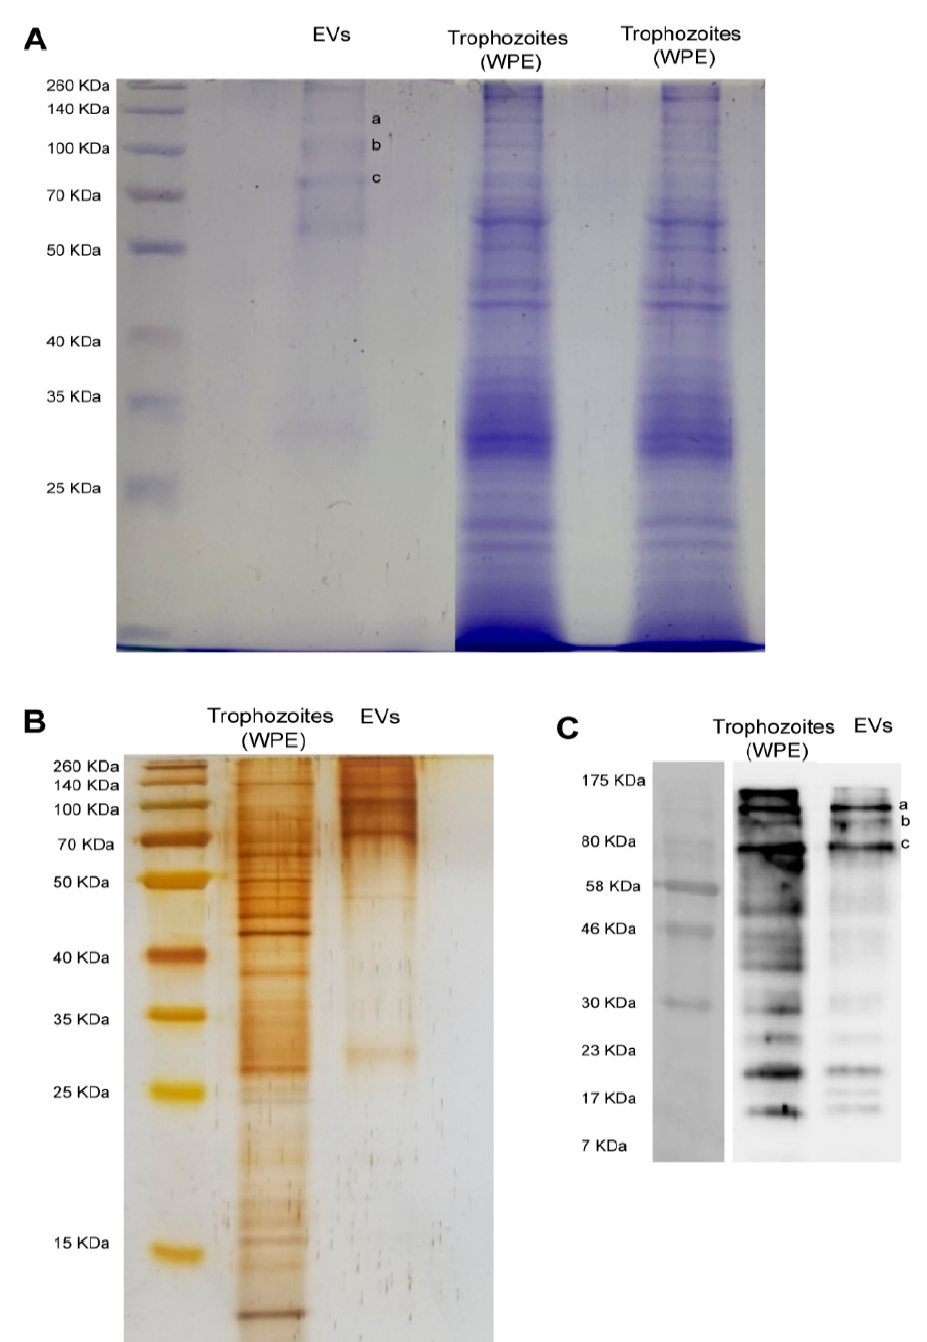
Figure 4. Electrophoretic (SDS-PAGE) protein profile of extracellular vesicles and protein recognition by polyclonal anti- Naegleria fowleri antibodies using Western blot. ( A ) Coomassie and ( B ) silver stains showing similar band patterns in extracellular vesicles, which range from >25 KDa to 260 KDa; EVs: extracellular vesicles; WPE: whole protein extracts of trophozoites of N. fowleri . For Coomassie stain, approximately 30 µ g of protein/sample were loaded onto the gel and for silver stain, approximately 9 µ g of protein/sample were loaded onto the gel. ( C ) Western blot showing the recognition of 3 intense bands over 70–80 KDa (( C ), a–c) and 3 less intense bands under 23 KDa, using the polyclonal anti- N. fowleri antibody (1:10,000) produced in rat. Bands over 70–80 KDa (( A ), a–c) were excised from Coomassie stained gels and submitted to nano-LC-MS/MS. Protein identifications are listed in Table